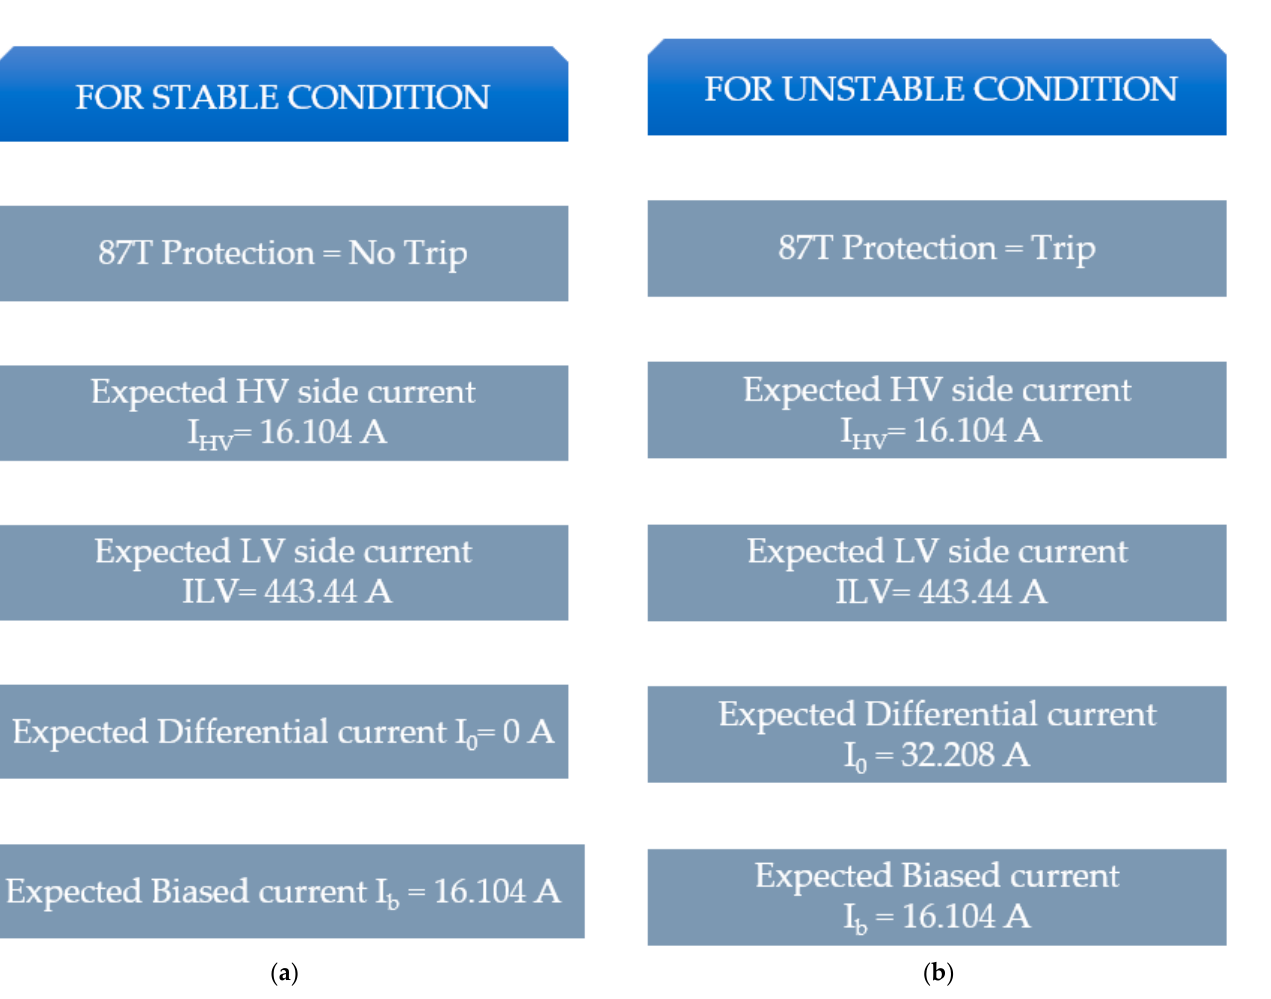
Figure 2. Expected results and relay operation for differential protection (87T) for the ( a ) stable condition and ( b ) unstable condition.